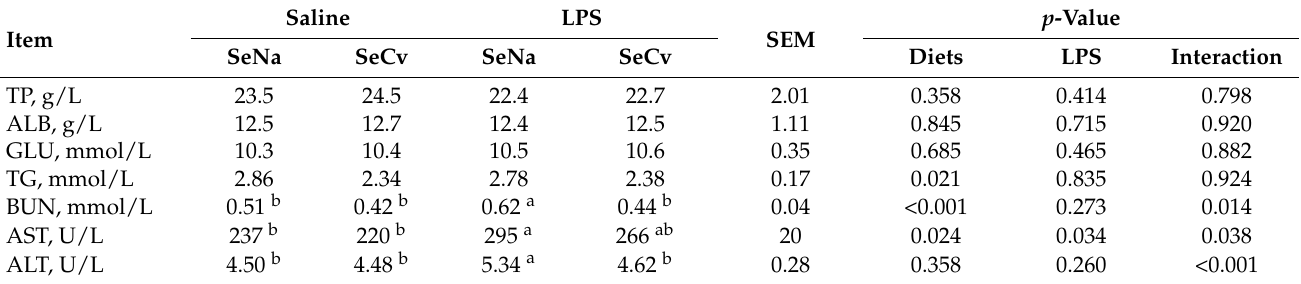
Table 1. Effect of Cardamine violifolia on plasma biochemical indicators of broilers challenged and unchallenged intraperitoneally with